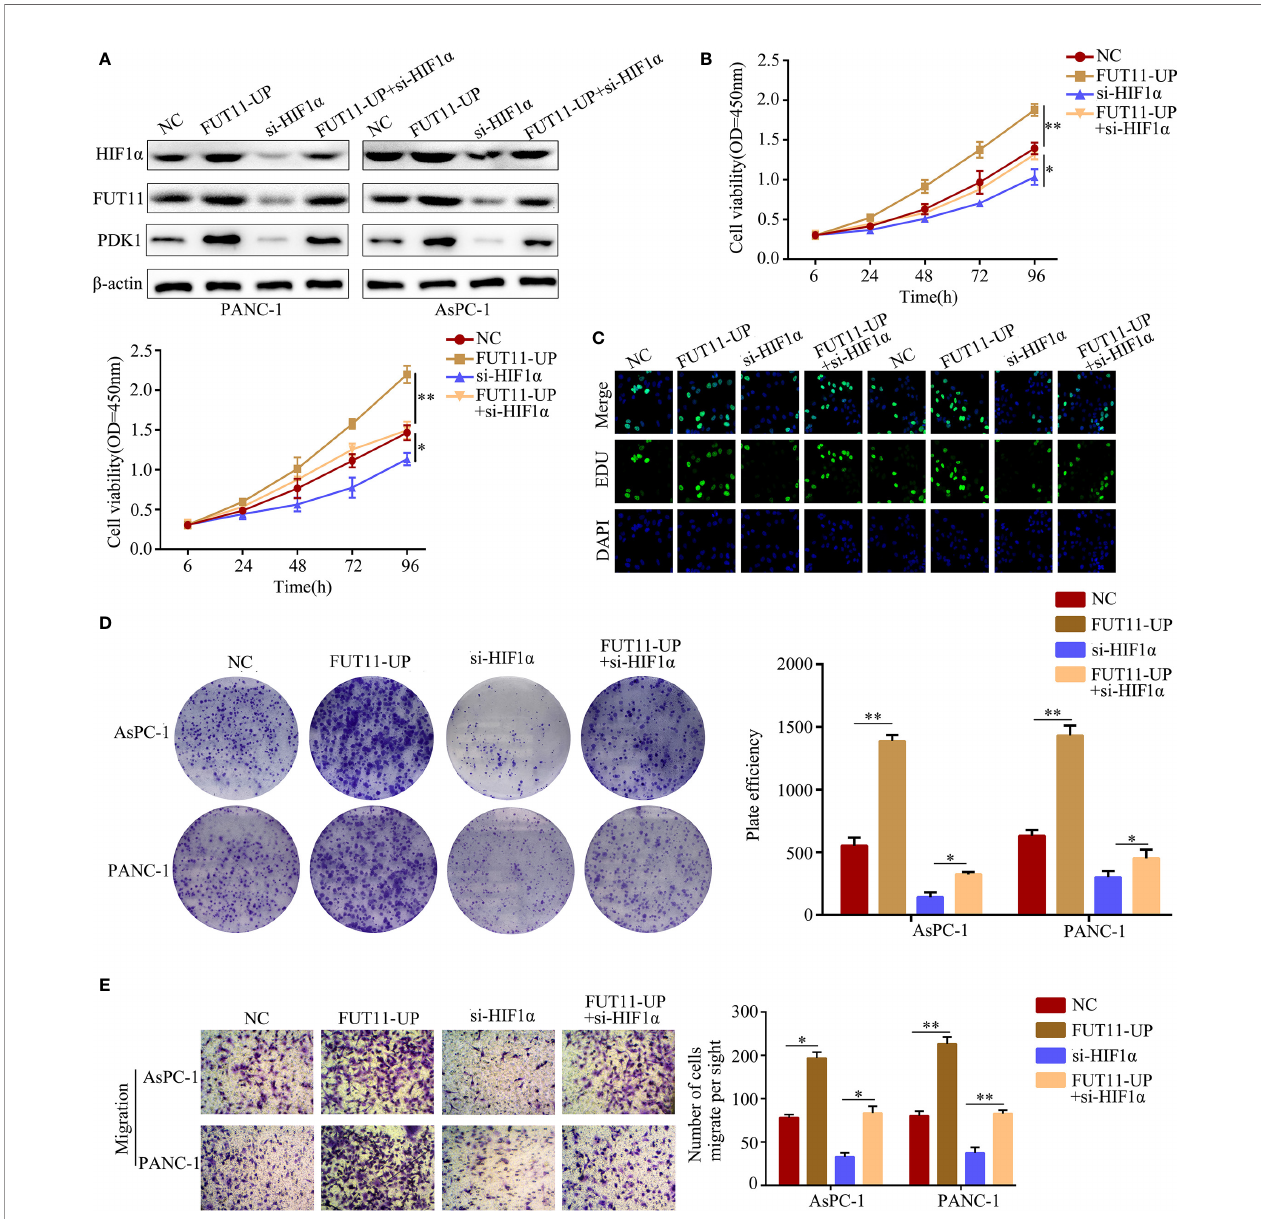
FIGURE 8 | Overexpression of FUT11 reversed the inhibitory effects of HIF1 a knockdown on PC cell proliferation and migration under hypoxia. PANC-1 and AsPC-1 cells were divided into four groups: negative control (NC); FUT11 overexpression (FUT11-UP); HIF1 a inhibition (si-HIF1 a ); HIF1 a inhibition plus FUT11 overexpression (si- HIF1 a +FUT11-UP). All groups of cells were cultured in hypoxia. (A) Western blot on the expression of HIF1 a and FUT11 in each group of cells. (B) CCK-8 assay on the cell viability in each group of cells. (C) EDU assay on the proliferation in each group of cells. (D) Colony formation assay on the colony forming ability in each group of cells. (E) Transwell assays on the migratory ability in each group of cells. The data were shown as means ± S.D. of three independent assays. * P < 0.05, ** P <